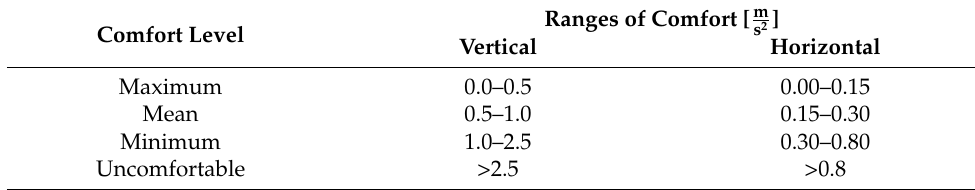
Table 5. The acceleration ranges associated with comfort levels (S É TRA